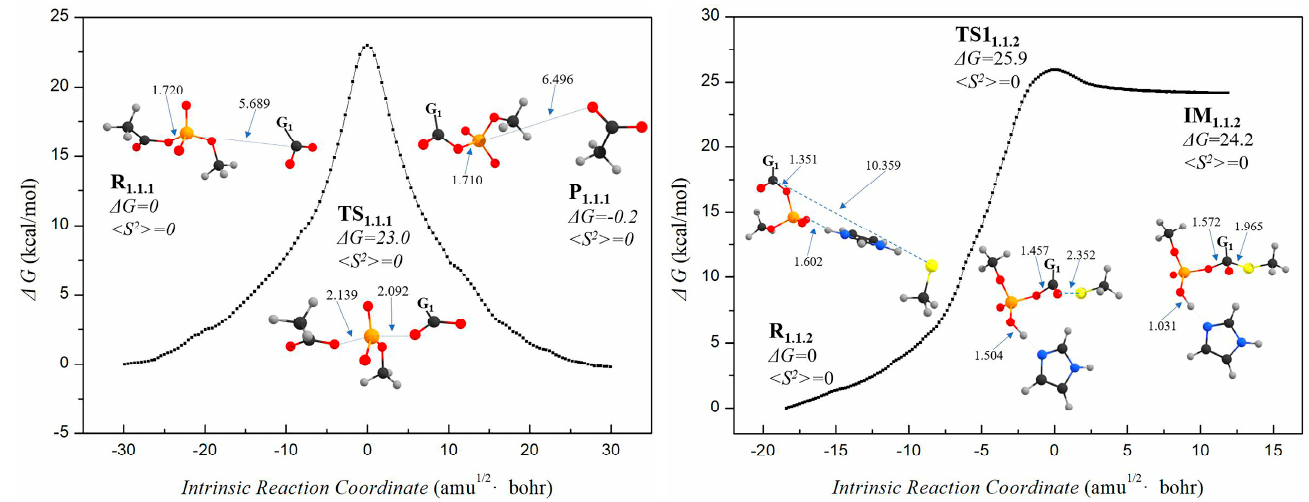
Figure 1. Under the calculated level of CAM-B3LYP/6 − 31+G**, the reaction potential energy curve and the key geometric parameters of each stable point of ( a ) the phosphorylation process (1.1.1), ( b ) the reaction potential energy curve, and the key geometric parameters of each stable point of the thioesterification process (1.1.2). Different ball colors represent different atoms, black: C, gray: H, red: O, orange: P, blue: N, yellow: S, and similarly hereinafter. The reaction mechanism can be seen in Schemes 3 − 6. Group G 1 is shown in Scheme 1.